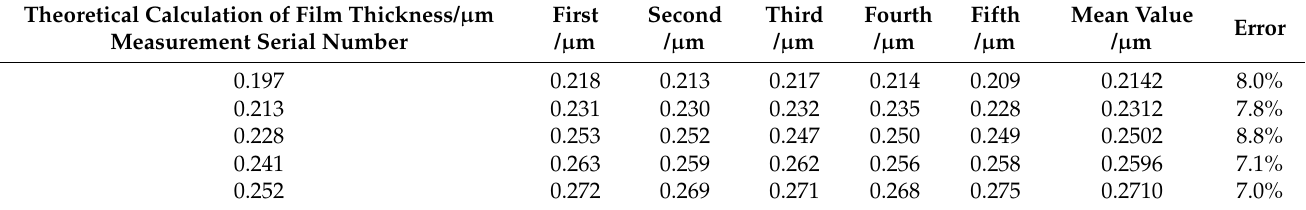
Table 4. Comparison of experimental measurement and theoretical calculation results at different speeds.